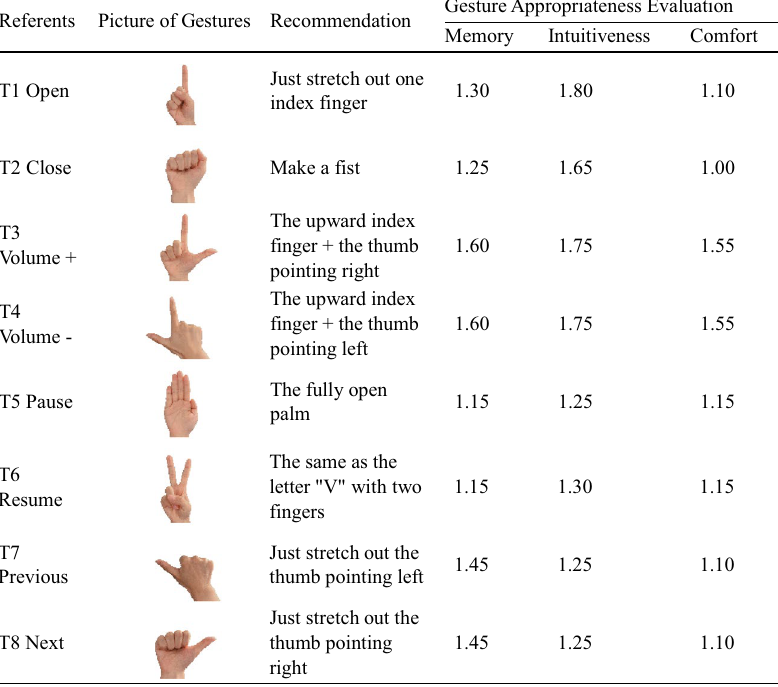
Table 6 User-defined gesture consensus set and appropriateness